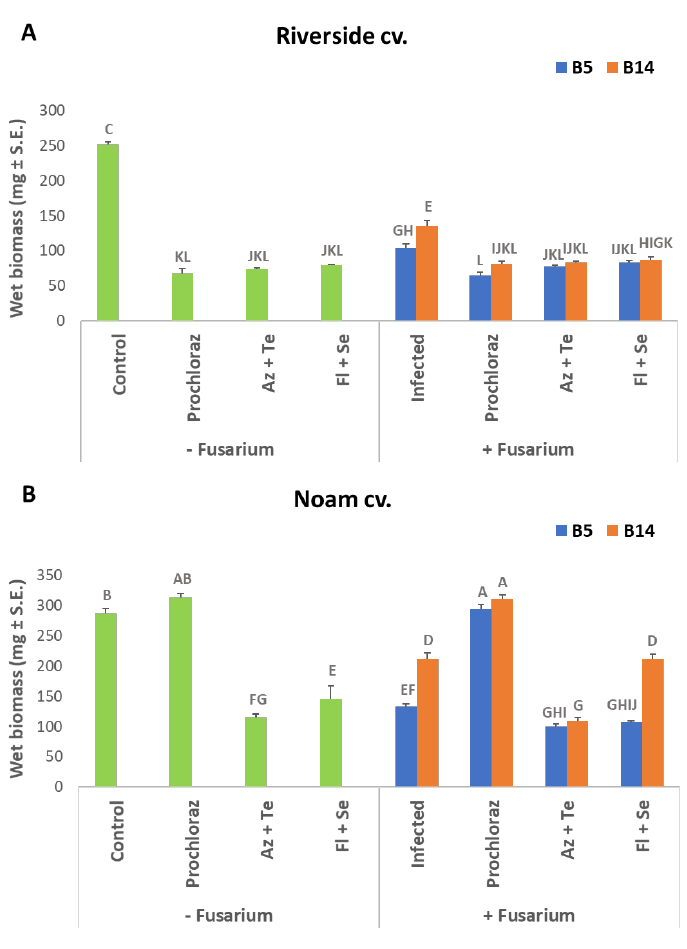
Figure 6. Average fresh biomass of Riverside and Noam genotypes onion seeds after Fusarium spp. inoculation and selected pesticide seed coating. The experiment and abbreviations are depicted in Figure 4. The columns represent an average of five repetitions, deviation lines represent a standard error. Different letters above the columns represent a significant difference ( p < 0.05) in the ANOVA test.